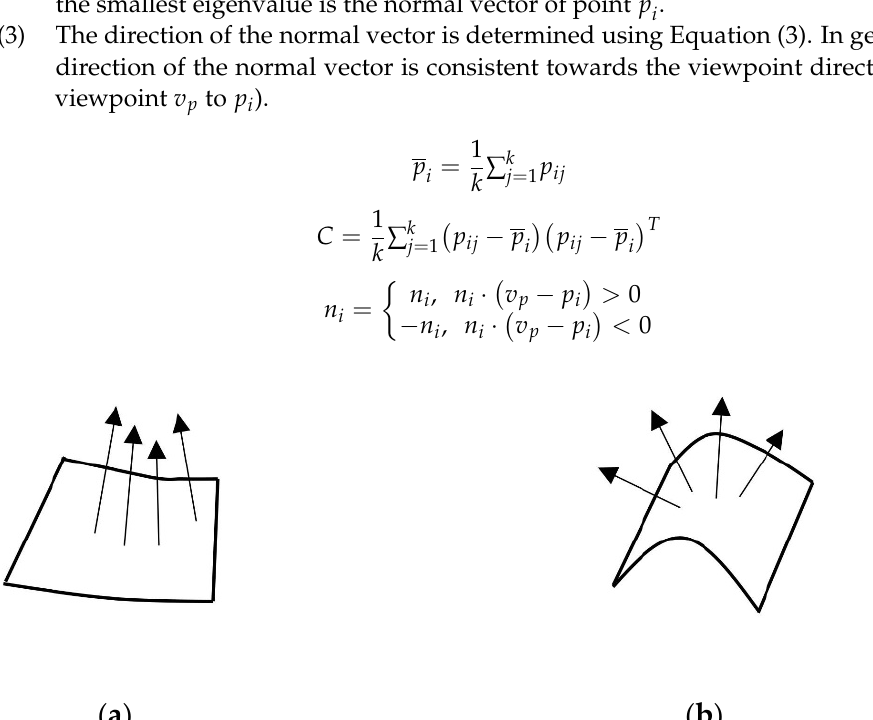
Figure 2. Normal vector reaction surface information. ( a ) Gradual region; ( b ) Abrupt region.